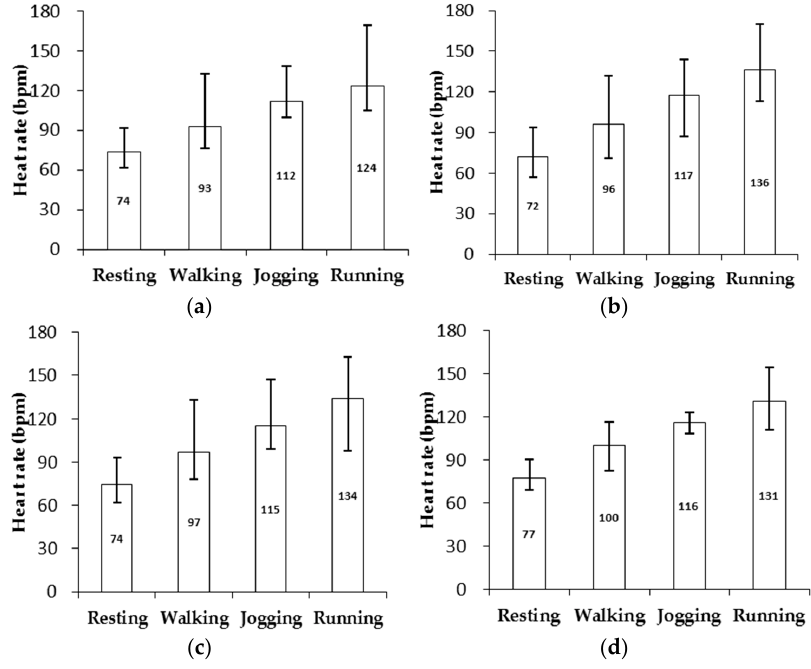
Figure 9. HR measurement results of different skin types at four types of exercises, i.e., resting, walking, jogging and running. ( a ) Mean HR and range (skin type I & II); ( b ) Mean HR and range (skin type III); ( c ) Mean HR and range (skin type IV); ( d ) Mean HR and range (skin type V).